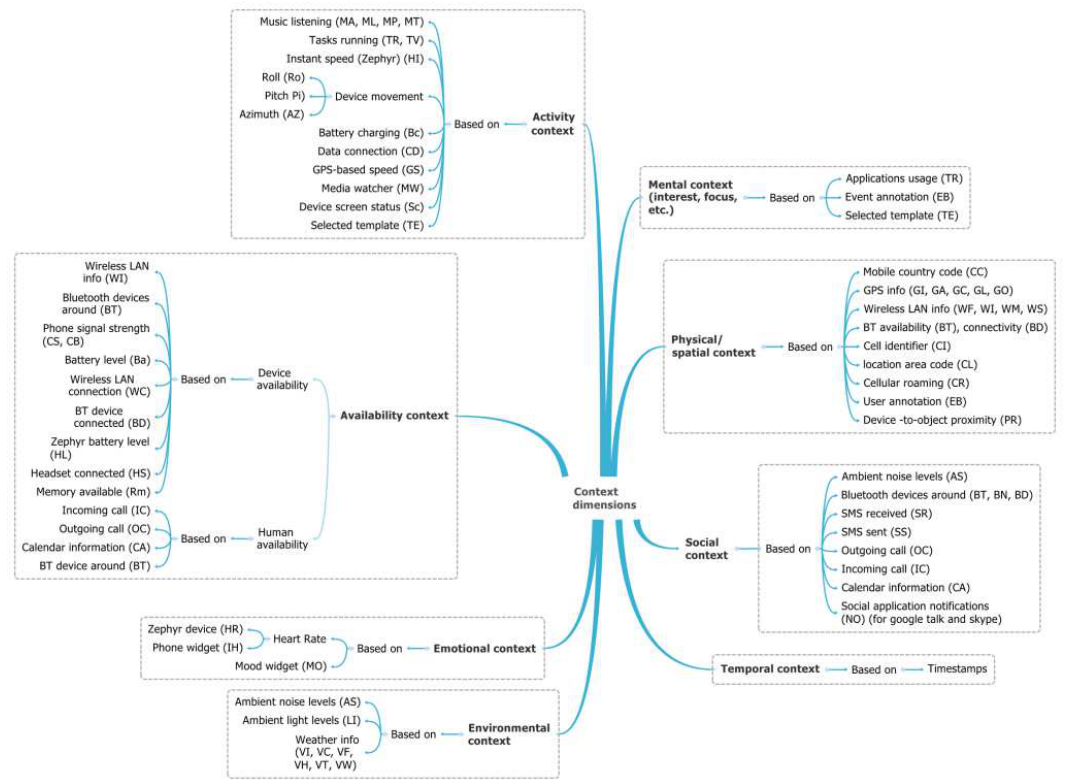
Figure 5 . Possible contexts to be determined from AIRS recordings